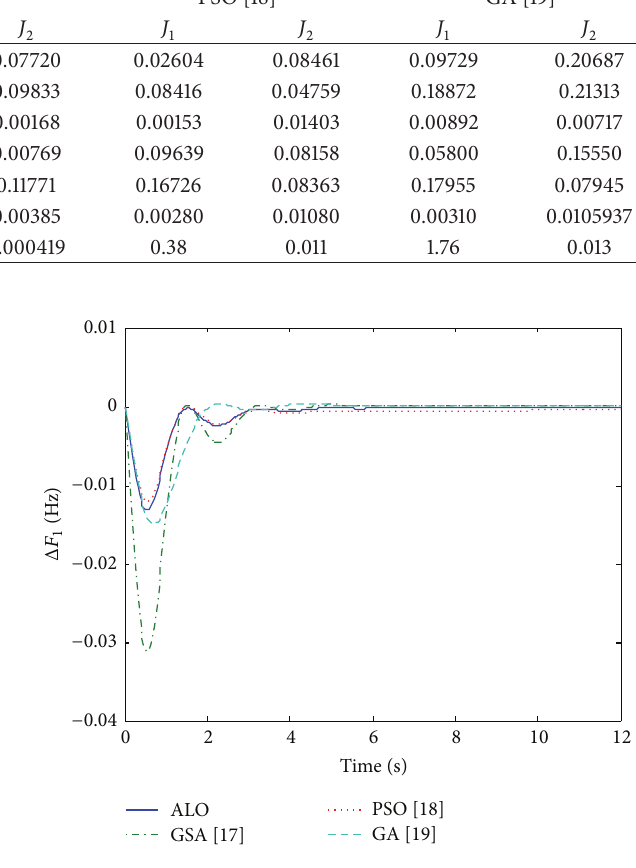
Figure 10: Change in frequency of area 1 by 25% load increase in area 1.